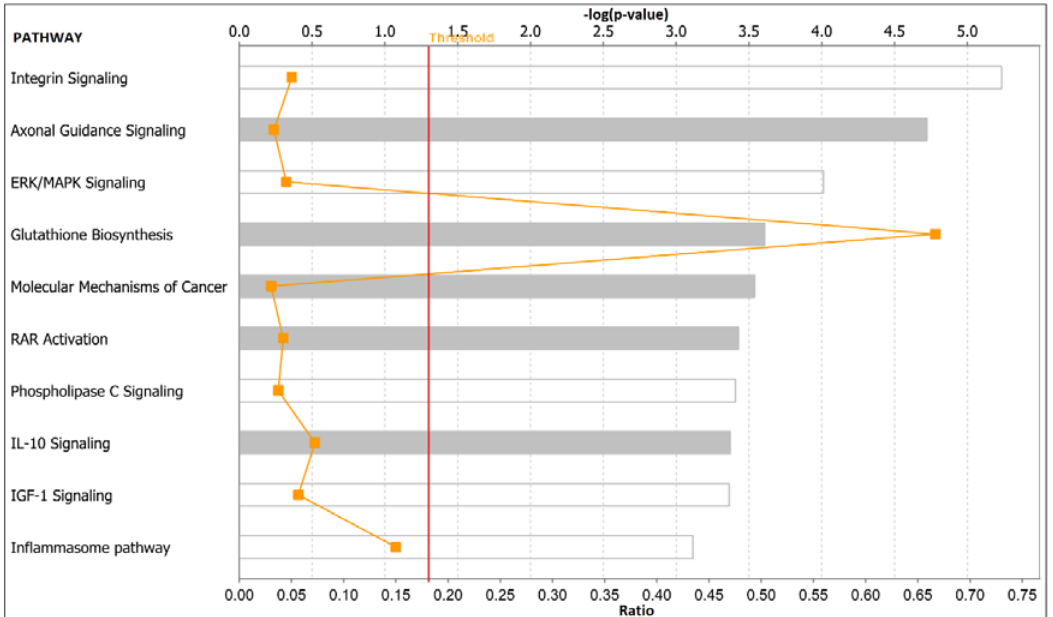
Figure 7. Molecular networks predicted to significantly associate obesity with TNBC in postmenopausal women. Gene symbols in red fonts were predicted to be highly significantly associated with obesity. Genes in black symbols are predicted to be functionally related.